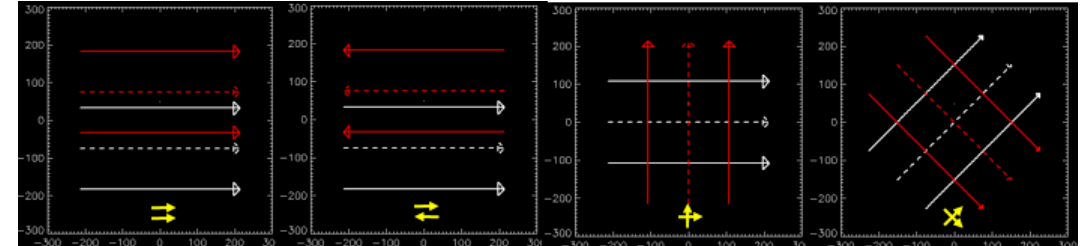
Figure 5. Preset flight patterns of the airborne lidar simulator.